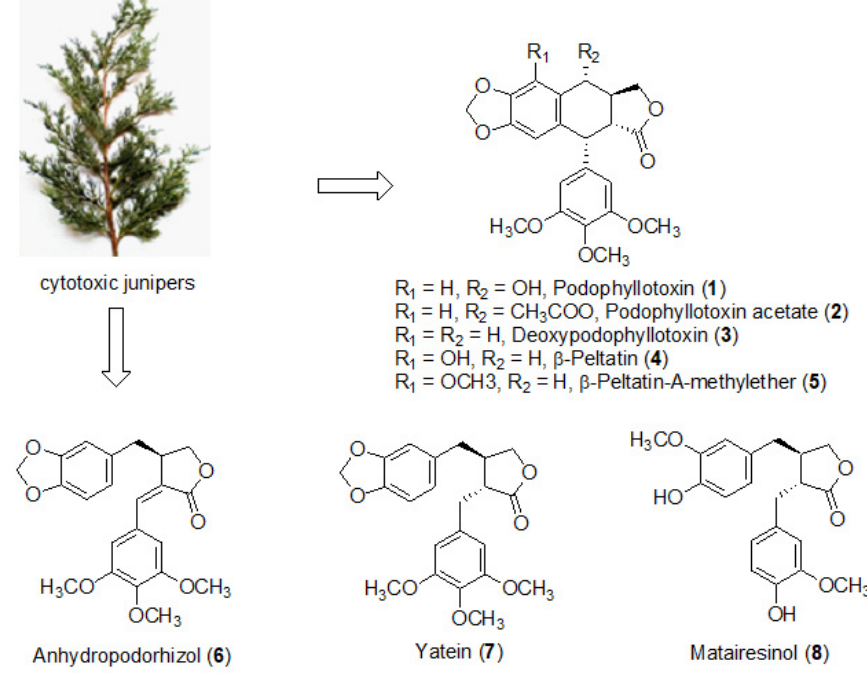
Figure 1. Structures of the lignans 1–8 , identified in the cytotoxic juniper leaf